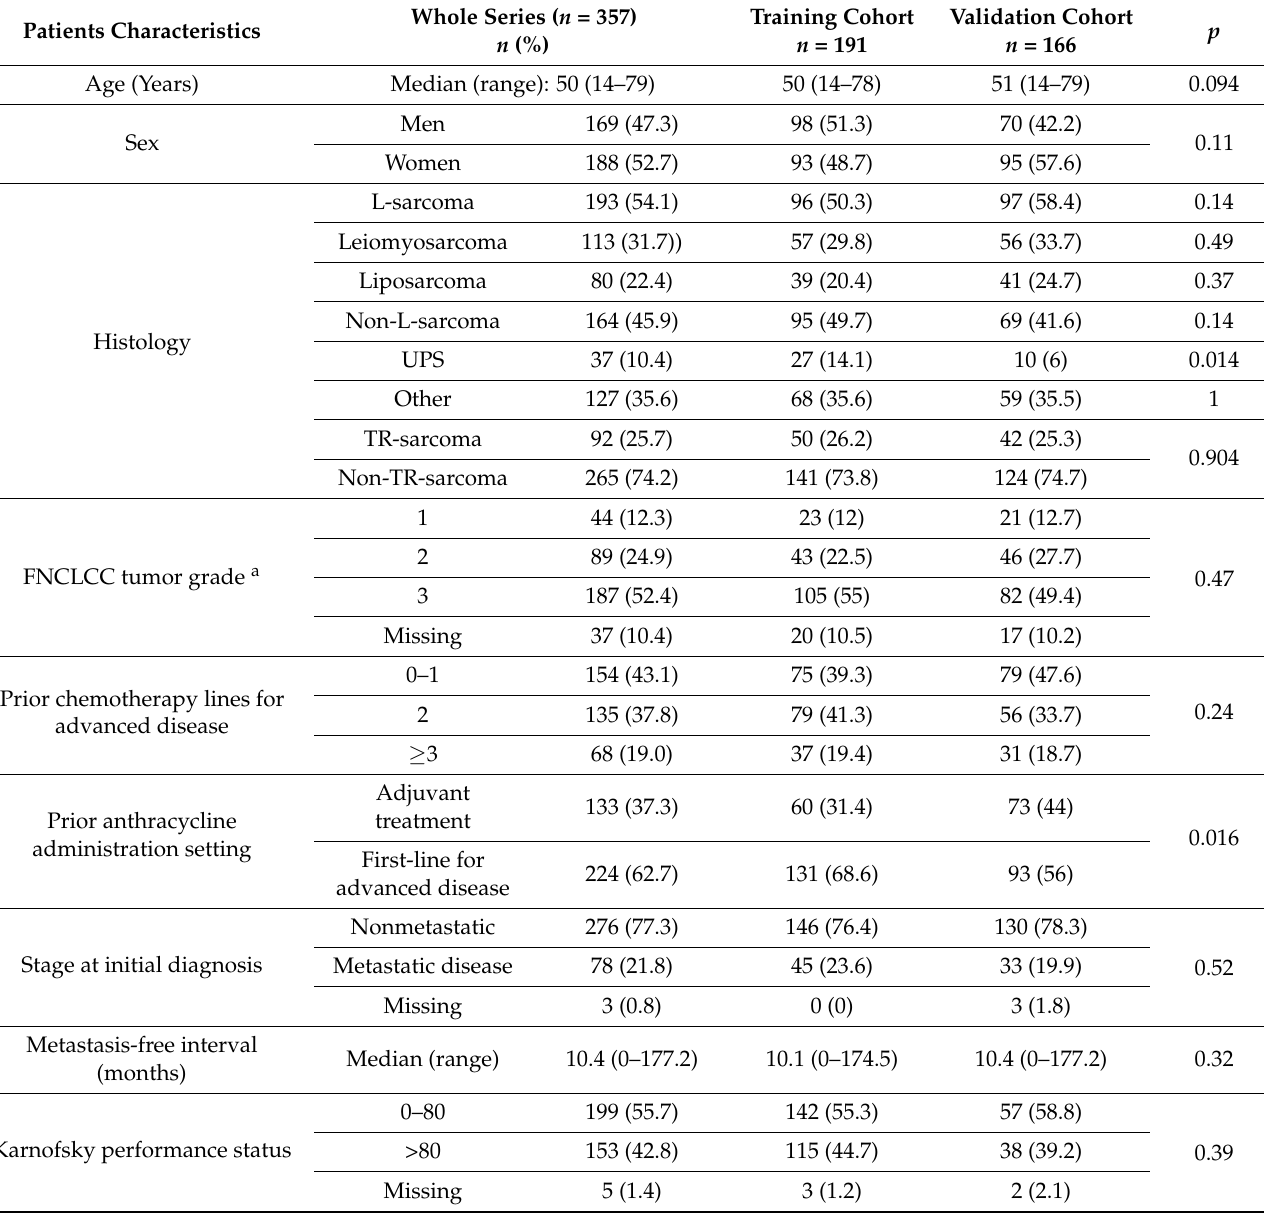
Table 1. Patients’